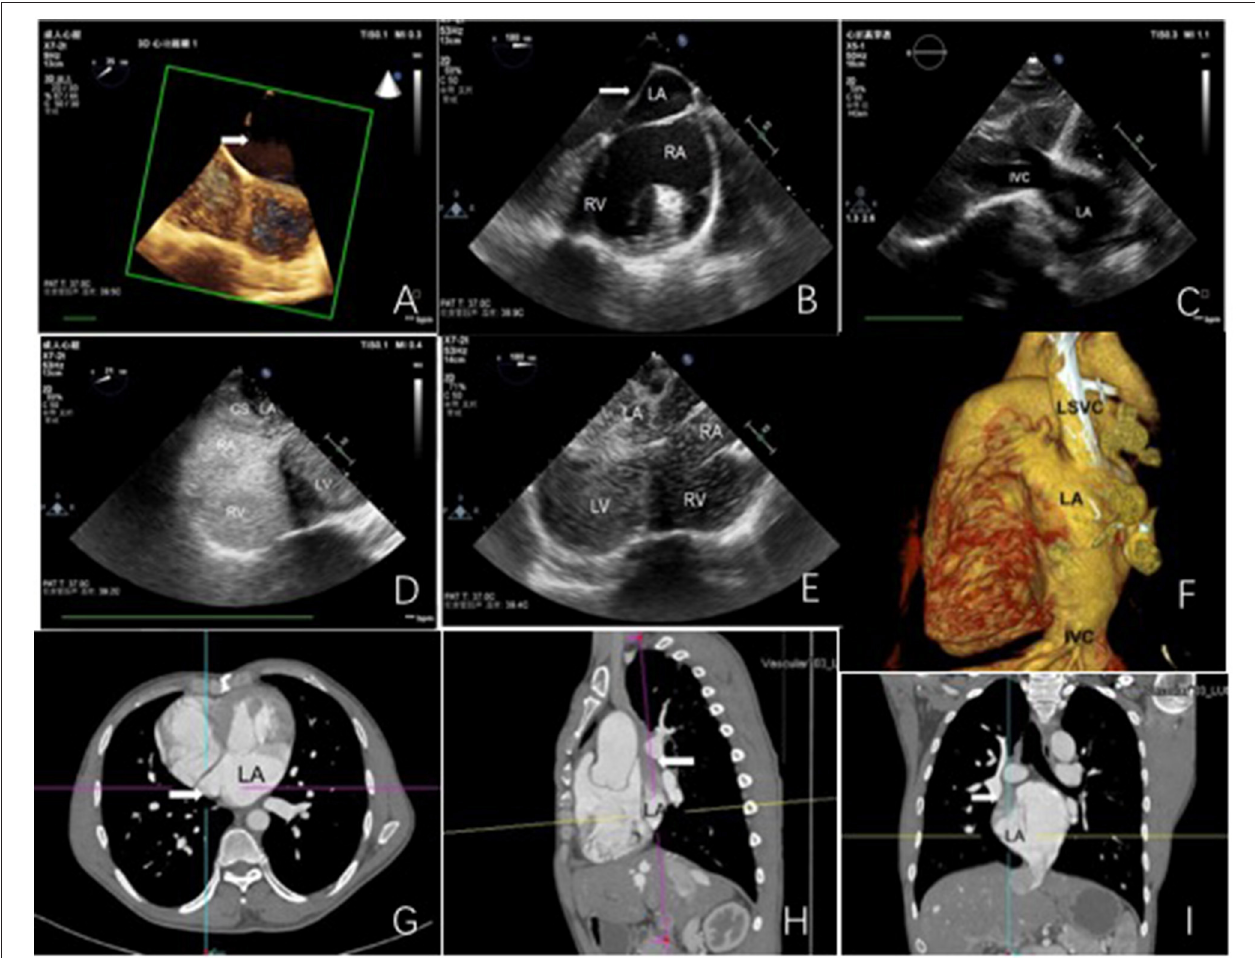
FIGURE 1 | Echocardiography and computed tomography angiography. (A) complete coronary sinus atrial septal defect (white arrowheads). (B) white arrowheads show an abnormal conduit. (C) A connection between the inferior vena cava and the left atrium. (D) saline microbubbles injected into the lower limb vein expressed first in the LA and left ventricle (LV), and then in the RA and RV. (E) saline microbubbles injected into the right elbow vein expressed almost simultaneously in the LA and RA. (F) CT shows the left superior vena cava and the inferior vena cava draining into the LA. (G–I) CT shows the superior vena cava (white arrowheads) draining into